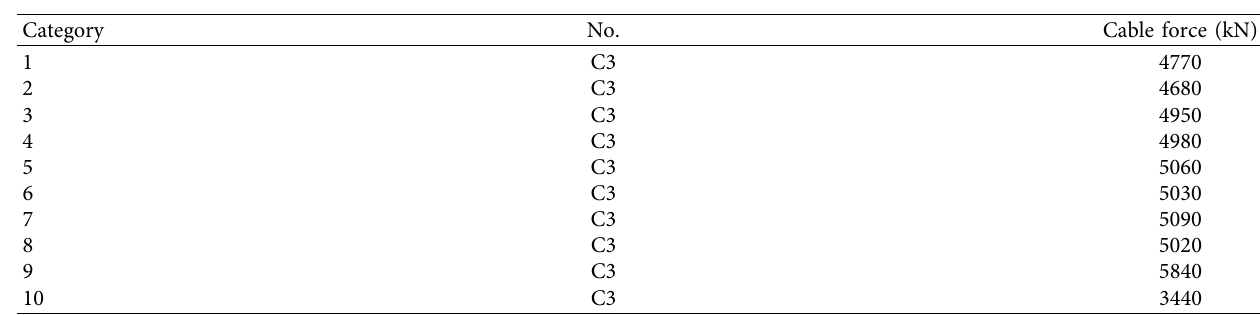
Table 6: Side inclined cable forces.